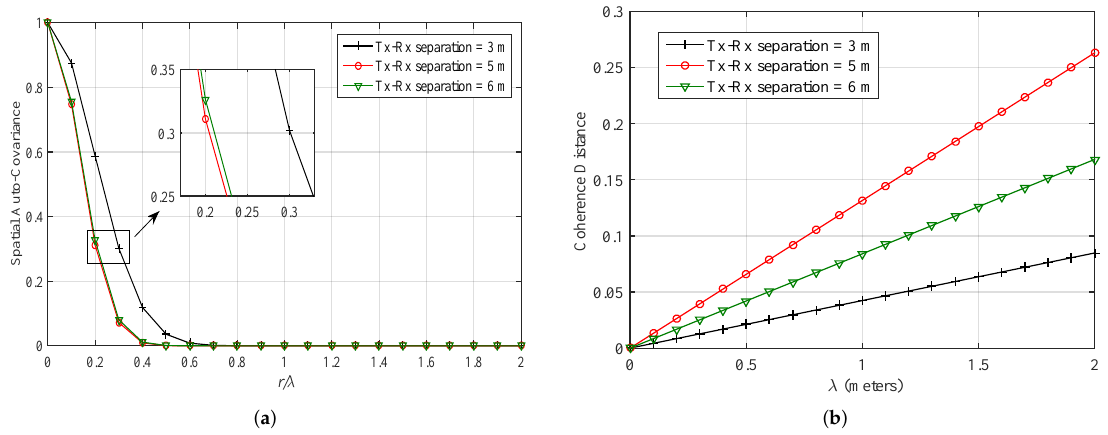
Figure 7. Spatial auto-covariance and CD for different scenarios of indoor mmWave (Case 2 (a); 28 GHz) radio propagation environments in ( a , b ), respectively. ( m = 1, f d = 10